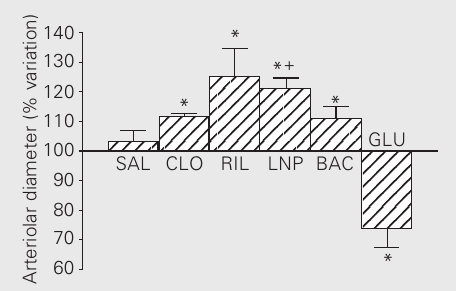
Figure 2. Maximum changes (percent of baseline) of mesen- teric arteriolar diameter. Varia- tions observed after intracister- nal injection of saline (SAL, con- trol group), clonidine (CLO, 1 µg), rilmenidine (RIL, 7 µg), LNP 509 (LNP, 60 µg), baclofen (BAC, 1 µg), or L-glutamate (GLU, 125 µg) in anesthetized spontane- ously hypertensive rats. Each set of points represents the mean ± SEM for 6 experiments. *P < 0.05 compared to the con- trol group. + P < 0.05 compared to the clonidine-treated group